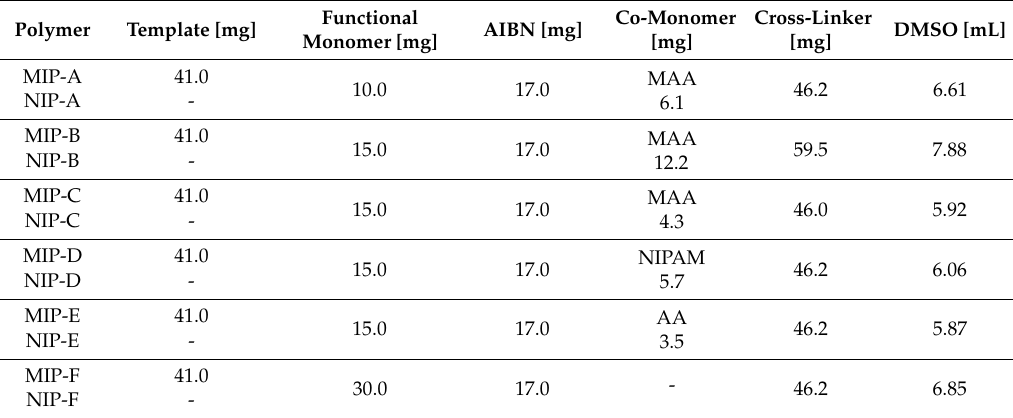
Table 1. Composition of the polymerisation